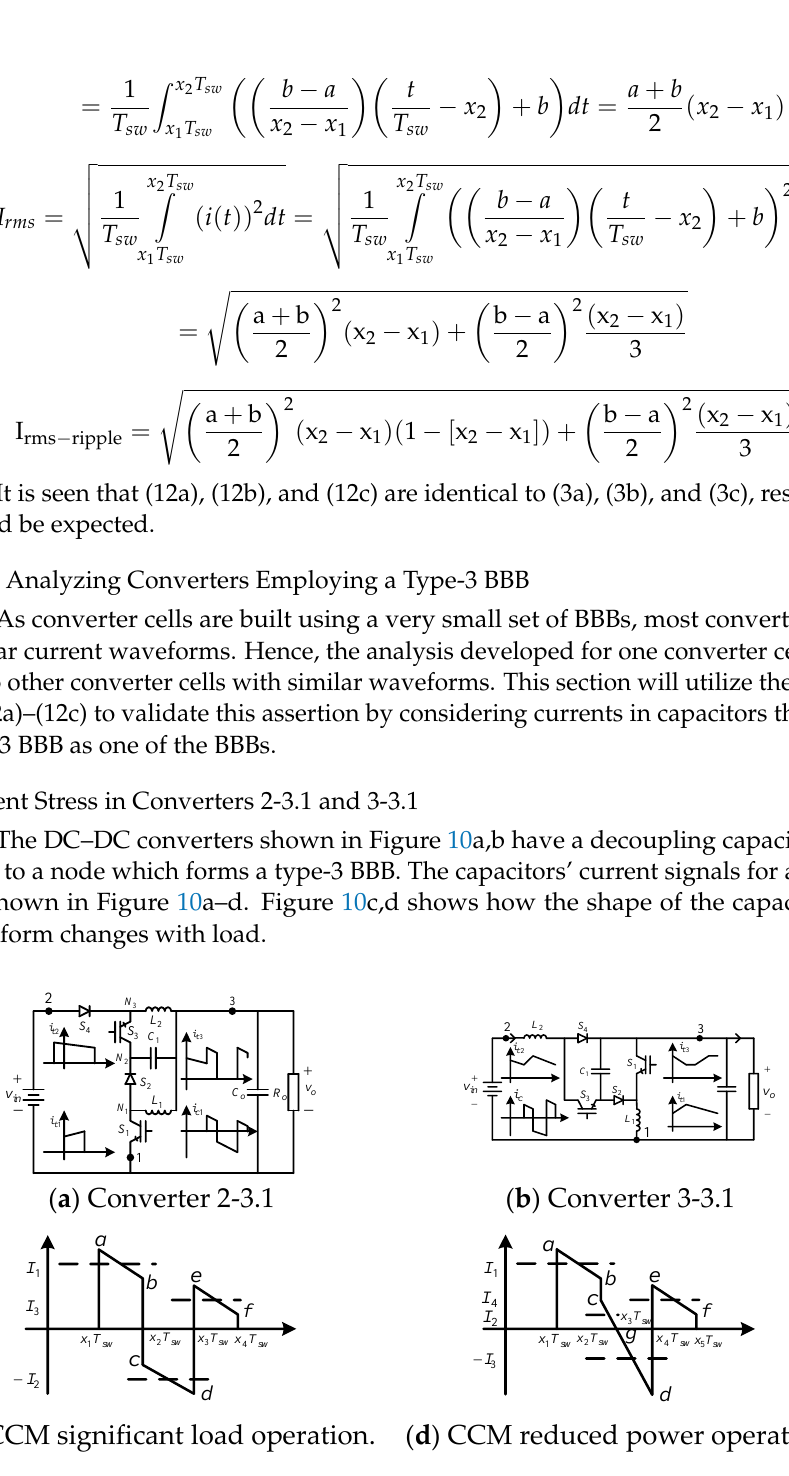
Figure 10. Some of the group 1 converters and their capacitor current waveforms . Figure 10c can be partitioned into three unique trapezoidal pulses. The nominal am-